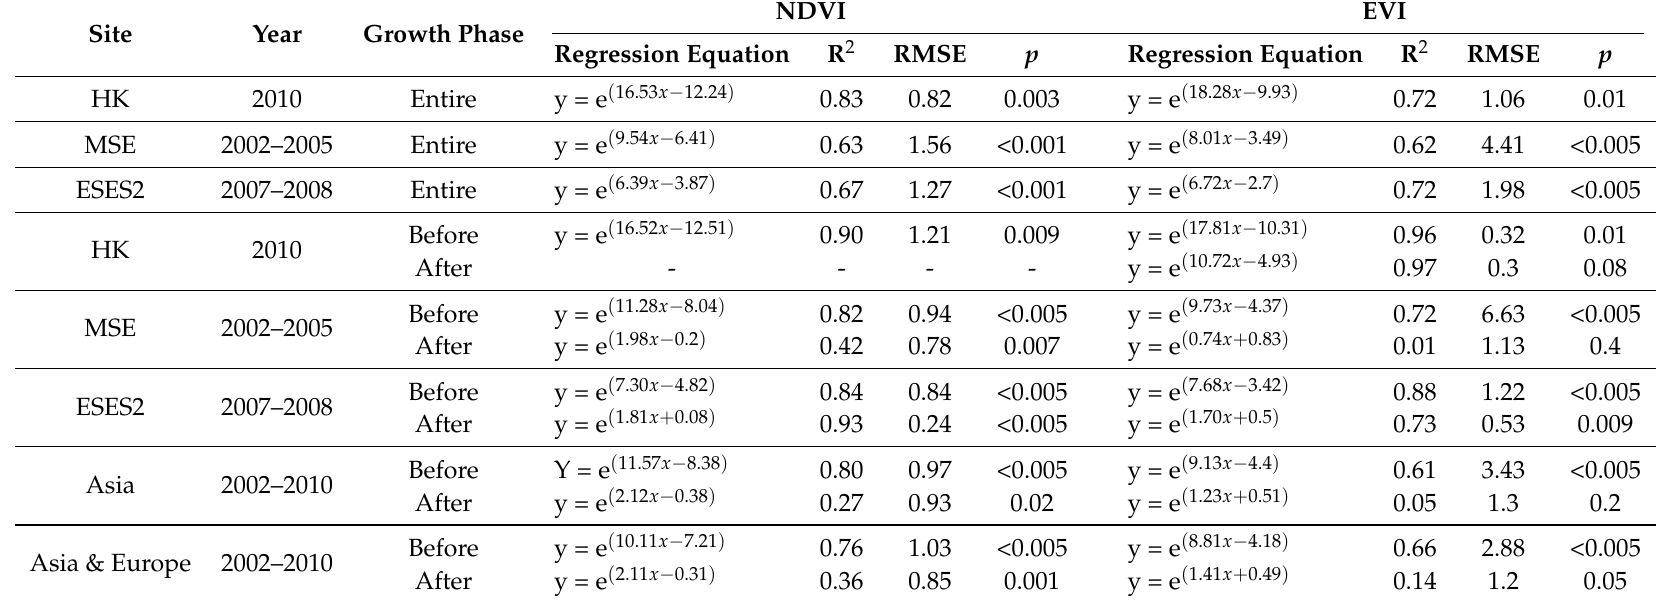
Table 2. Summary of regression analyses between LAI and NDVI and between LAI and EVI. The analysis was conducted using the data from different growth phases: “Entire” indicates the data from the entire growing season. “Before” indicates the data collected before the maximum VI, whereas “After” indicates the data collected after the maximum VI. R 2 is the adjusted coefficient of determination, and RMSE is the root mean square error. HK = Haean (S. Korea), MSE = Mase (Japan), and ESES2 = El Saler-Sueca